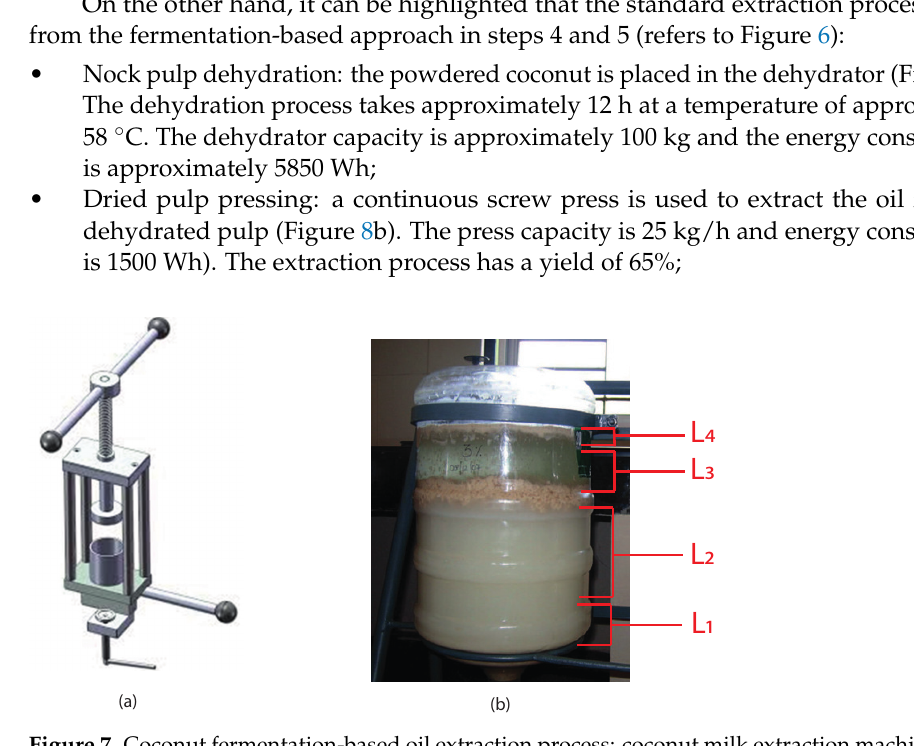
Figure 7. Coconut fermentation-based oil extraction process: coconut milk extraction machine ( a ) and coconut milk fermentation container ( b ).